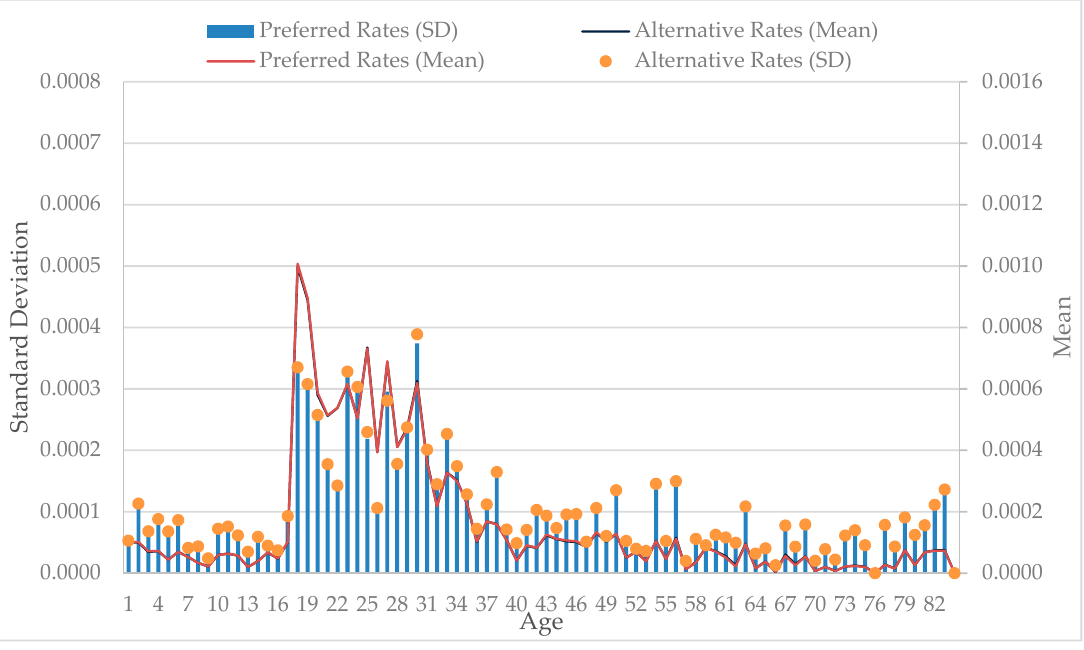
Figure 3. Means and Standard Deviations of Male Domestic In-Migration Rates, 2007–2014. Source: 2006–2014 1-Year American Community Survey.